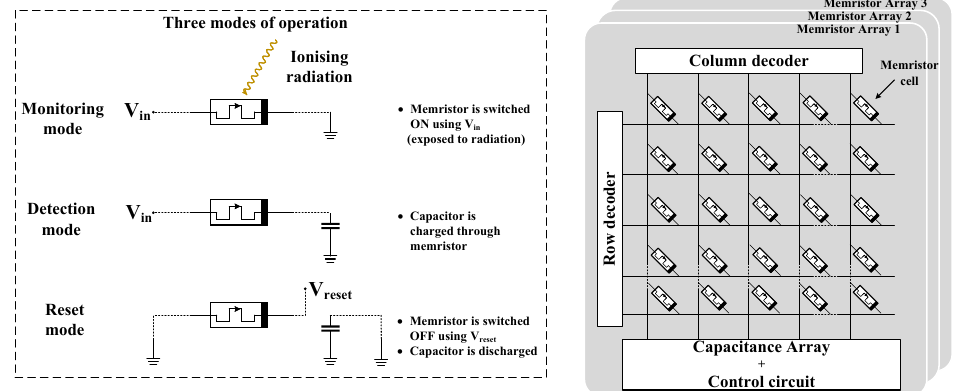
Figure 10. Illustration of a memristor based radiation sensor and its working principle .